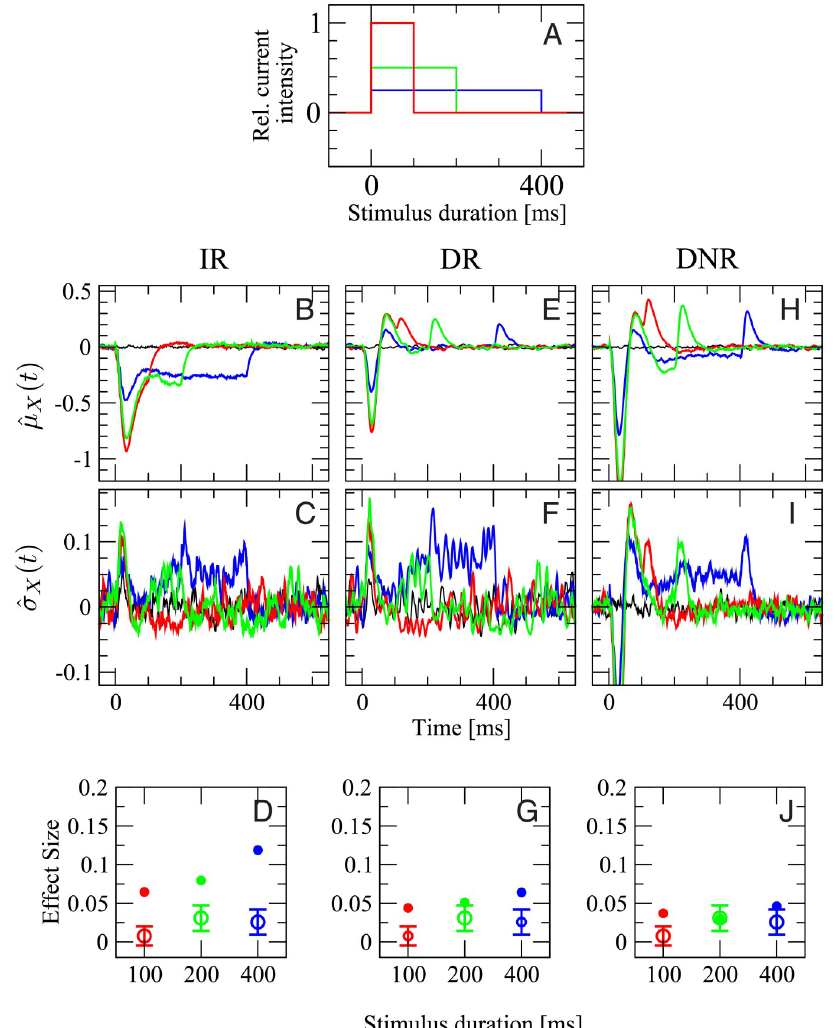
Fig 8. Only results from DR and DNR are consistent with the experimental data for the stimulation with stimuli of intensity inversely proportional to the duration (signals are shown in A). Panels B - J are organized as panels C - K of Fig 7 with the same color coding. Open circles with error bars in D , G , and J are the experimental average effect size measured from 55 RS cells (1469 total